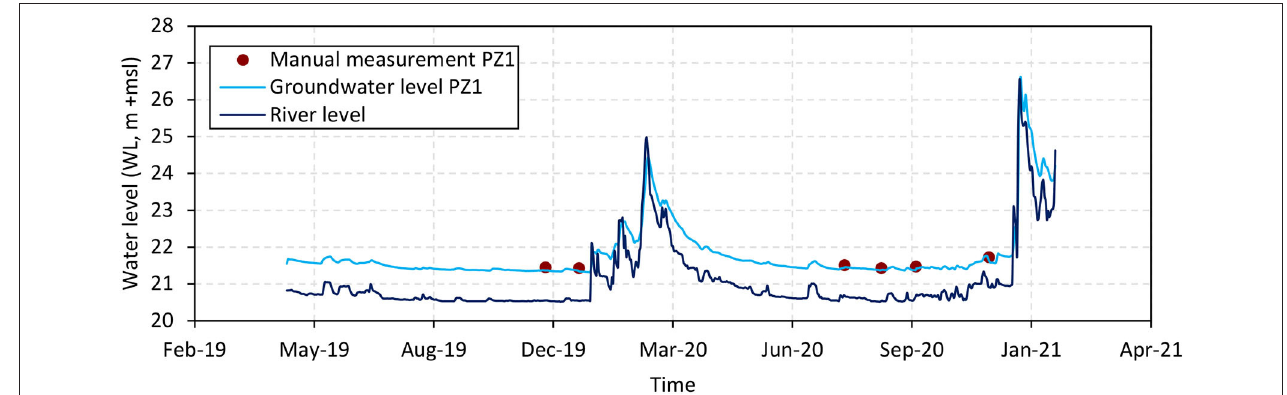
FIGURE 7 | Average monthly groundwater hydrodynamic levels from monitoring well PZ1 in the Guijá site and the corresponding water levels in the Limpopo River for the period of March/2019–January/2021. Manual measurements were used to validate the recorded data from the pressure transducer.